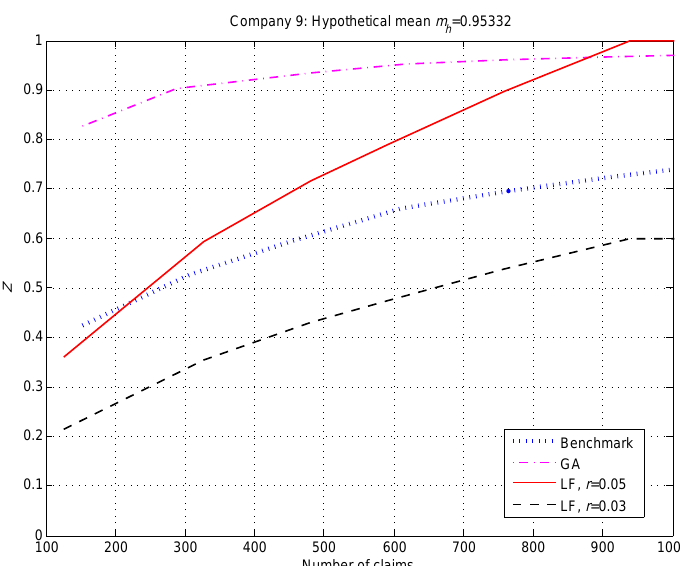
Figure 4. We contrast the Benchmark, GA, and LF credibility factors for “company” (risk class) 9, whose hypothetical mean is m 9 ≈